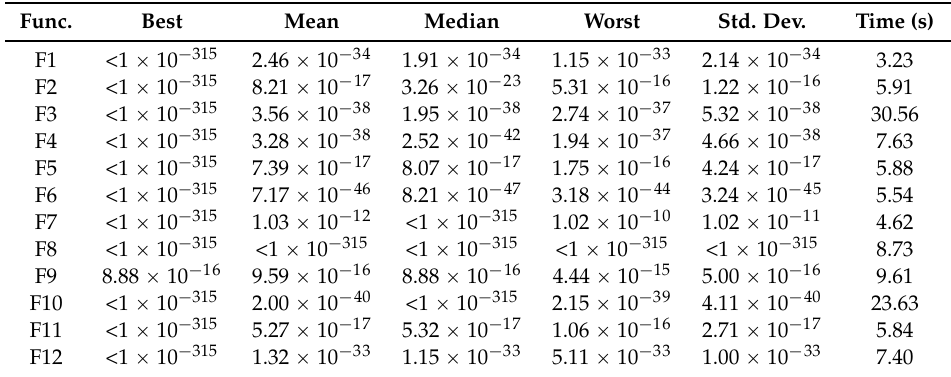
Table 2. Statistical results for OAFWA.